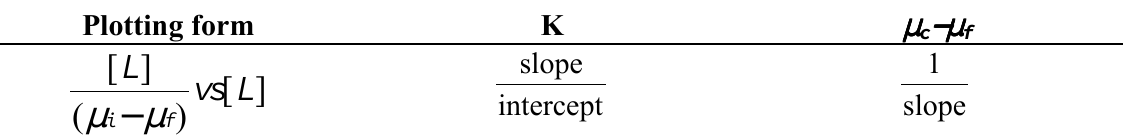
Table 4. Plotting method of Eq.